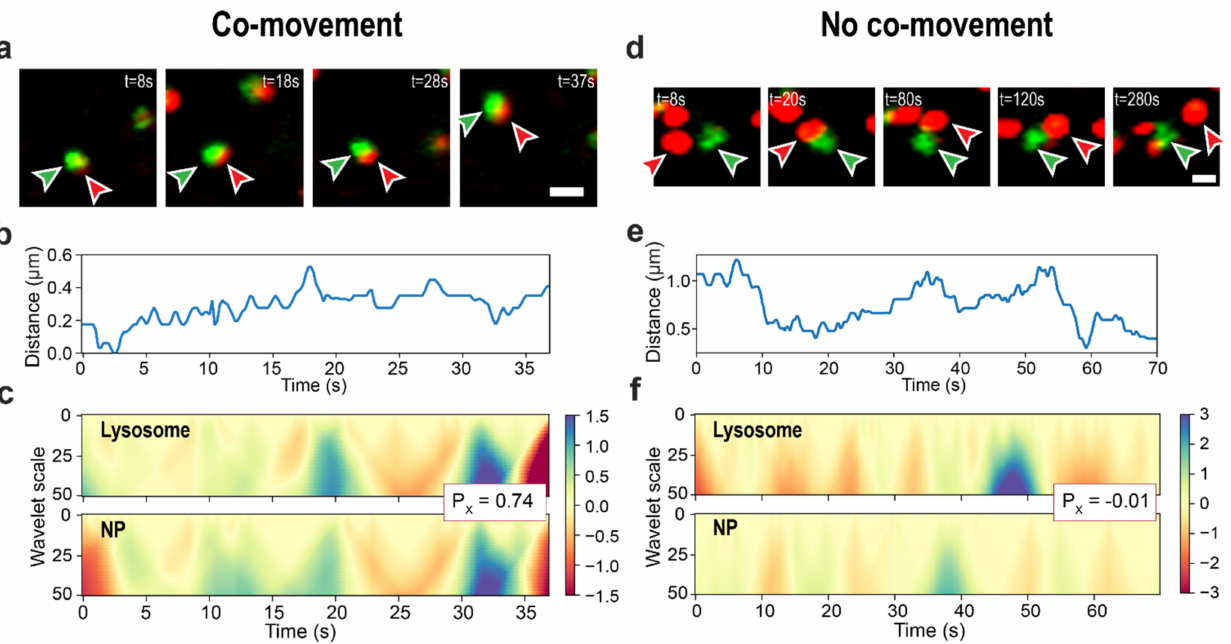
Figure 3. Examples of classification by the co-movement detection method. Lysosome–NP cluster pairs are correctly classified as moving together ( a – d ) and separately ( d – f ). ( a , d ) are lysosome (red) and NP-aggregate (green) experimental images prepared by combining images from the correspond- ing microscope channels. Arrows indicate the objects from the analyzed pair; the scale bars are 1 µ m. ( b , e ) are center-to-center distances of the pairs. ( c , f ) demonstrate CWT coefficient maps for trajectories’ x -axes. Inset box with P x values show the Pearson’s correlation coefficient between lysosomal and NPs-aggregate CWT coefficient maps. For clarity, data only from the 0-70 s time interval (out of 300 s) are shown on ( e , f ). See Supplementary Movie